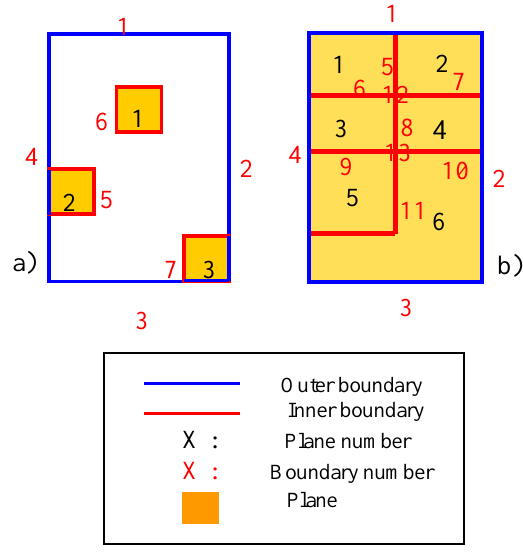
Figure 5. Representation of two roof planes types; a) Representation of single adjacency planes; b) Representation of multiple adjacencies planes